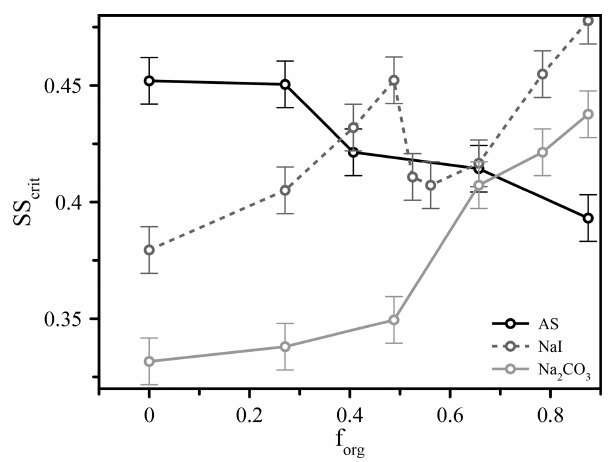
Figure 3. The measured critical supersaturation for 50nm dry di- ameter particles comprised of different salts (ammonium sulfate, sodium iodide, and sodium carbonate) and variable volume frac- tions of suberic acid ( f org ) at T ≈